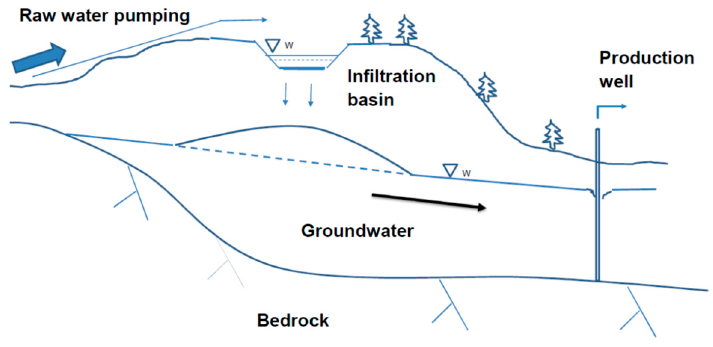
Figure 1. A schematic of a managed aquifer recharge (MAR) process in drinking water production.